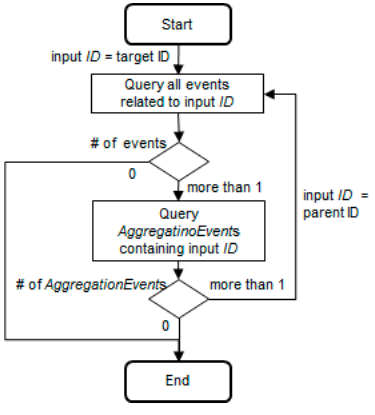
Figure 5. Pedigree algorithm for a site.